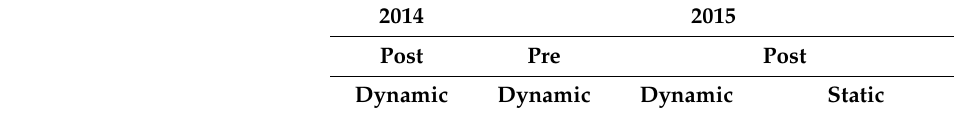
Table 1. Summary statistics. This table presents the summary statistics of our data during the sample period. Panel A reports the characteristics of stocks with and without VI occurrences during the sample period, Panel B shows the descriptive statistics on dynamic and static VI occurrences, and Panel C presents the distribution of VI occurrences across prices in each subsample period. In this table, the results for the pre-event (post-event) period in 2015, which is from 8 April 2015 to 12 June 2015 (15 June 2015 to 17 August 2015), is denoted as “2015” and “Pre” (“Post”). The results for the post-event period in 2014, which is from 1 September 2014 to 7 November 2014, is denoted as “2014” and “Post”. The columns assigned as “Dynamic” and “Static” indicate the descriptive statistics on dynamic and static VI occurrences, respectively. VOLUME _ SHARE ( VOLUME _ VALUE ) indicates daily trading volume in shares (in million Korean Won, KRW) and MKT _ CAP is market capitalization in million KRW. PRC is the closing price in KRW and for volatility measure, STD _ DEV is the standard deviation of daily returns and INTRA _ VOL is the intraday volatility measured by the daily highest and lowest price.